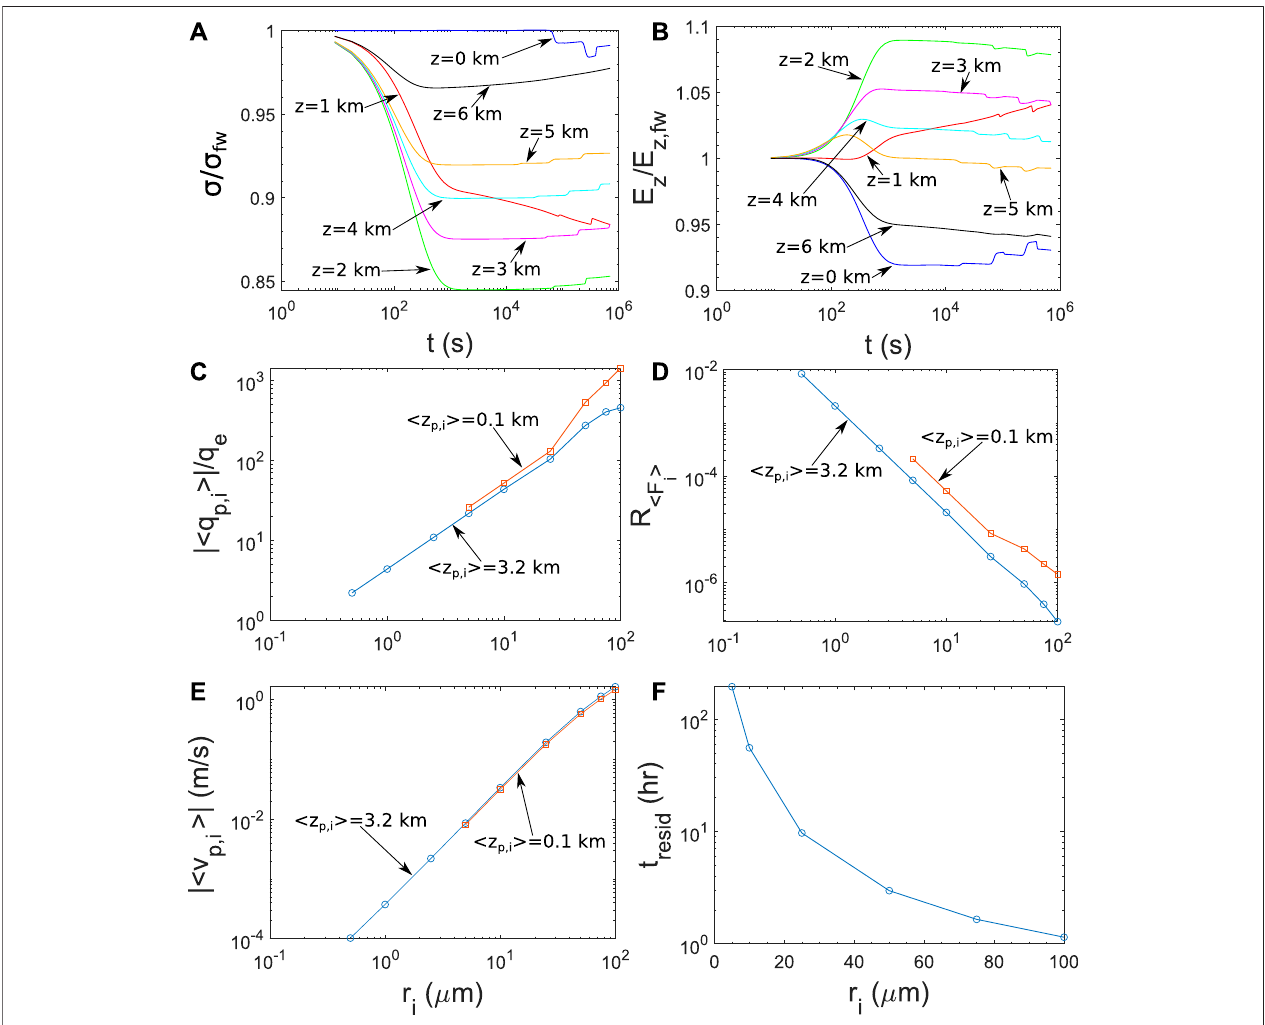
FIGURE 8 | Characteristics of particles distributed along the altitude according to N I p , i : (A) Conductivity reduction with respect to the fair weather value at different altitudes over time, (B) electric fi eld magnitude modi fi cation with respect to the fair weather value at different altitudes over time, (C) average number of elementary charges per particle as a function of particle radius for different average bin distribution altitudes, (D) ratio between average electrical force magnitude and gravity magnitude as a function of particle radius for different average bin distribution altitudes, (E) average particle velocity as a function of particle radius for different average bin distribution altitudes, (F) residual time of particles in the atmosphere until 99.9% of their concentration is lost.